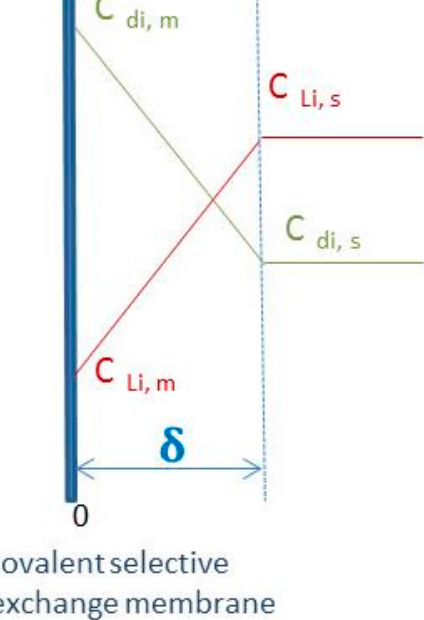
Figure 5. Schematic representation of the concentration profiles of lithium(I) ions and divalent cations near the cation-selective membrane ( δ : thickness of diffusion boundary layer, C Li,s : lithium concentration in solution, C Li,m : lithium concentration at the membrane surface, C div,s : divalent cation concentration in solution, C div,m : divalent cation concentration at the membranes’ surface).